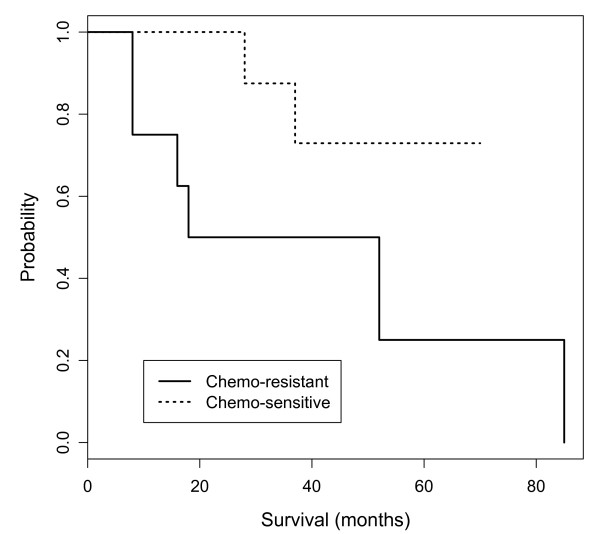
Kaplan-Meier estimates of overall survival stratified by chemo-resistance.